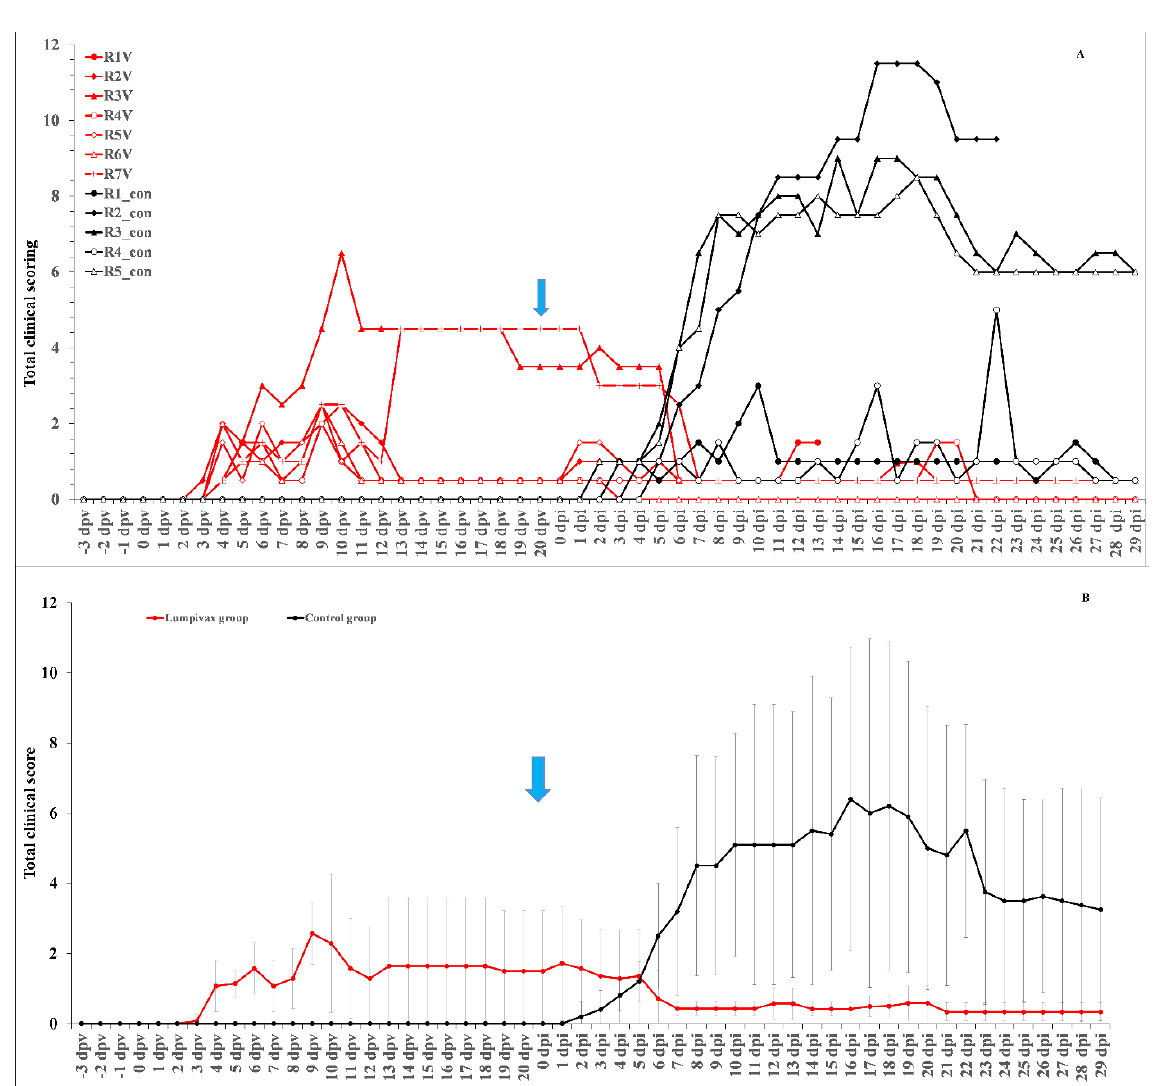
Figure 1. Total clinical of the Lumpivax and control group as individual scores ( A ) or as group average ( B ) whereby the variation is shown as error bars. Blue arrow: moment of challenge.